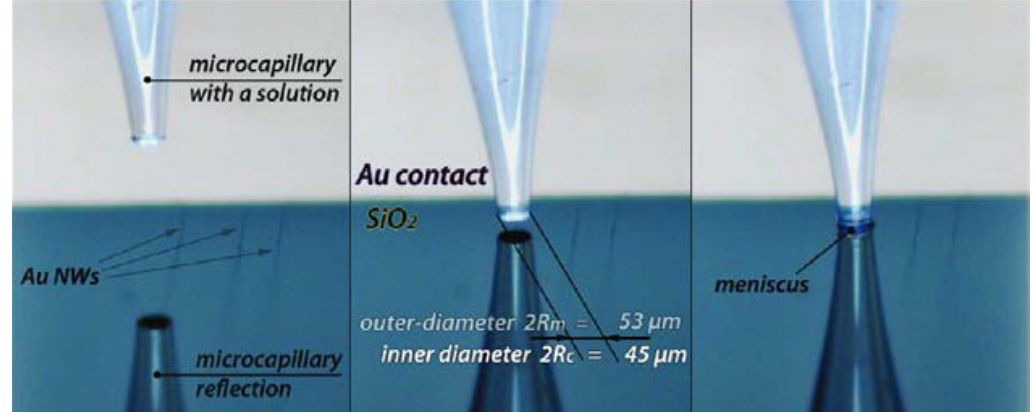
Figure 5. Process of microcapillary positioning over GNWs and the contact of the solution meniscus with the NW electrode. Reprinted with permission from [100]. Copyright 2011, American Chemical